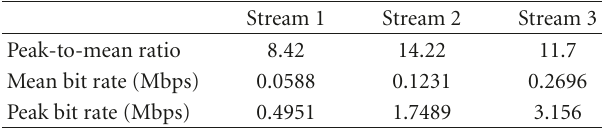
Table 3: Characteristics of the videos used in the simulation. Stream 1 Stream